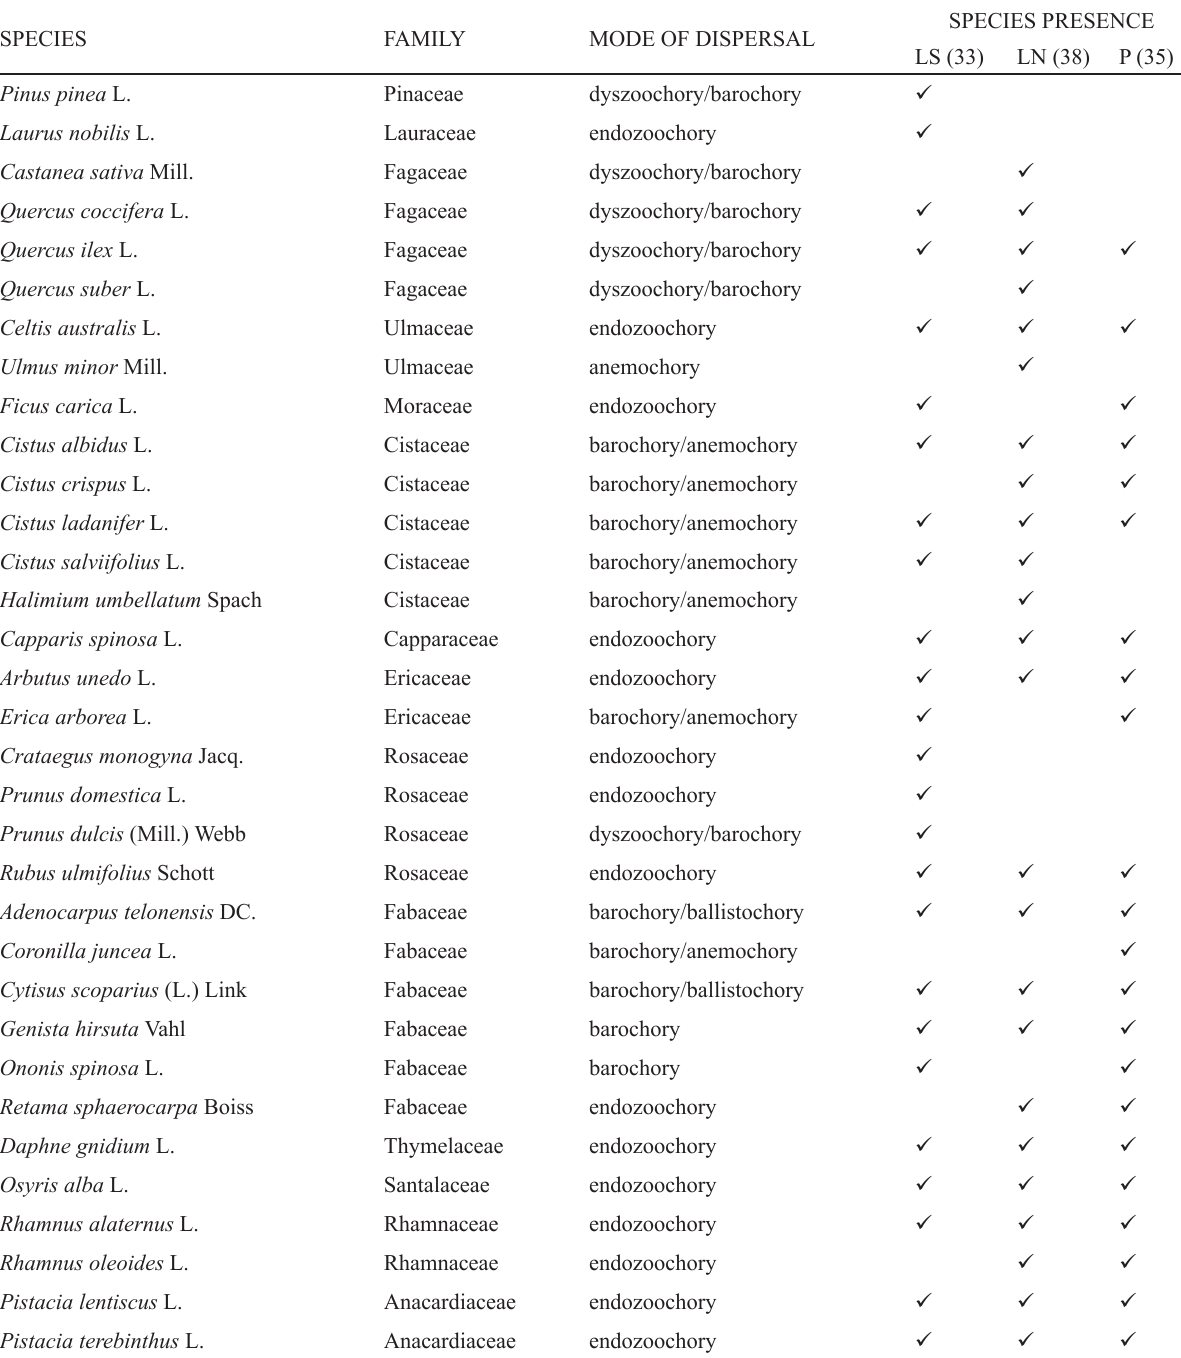
Table 1. List of sampled plant species and their main characteristics. Species are classified into and (ordered by) taxonomic families (according to López Tirado, 2018) and most common mode of seed dispersal is also noted (Alday et al. , 2011; Bonet & Pausas, 2004; Debussche & Lepart, 1992; González-Varo et al. , 2015; Herrera, 1995; La Mantia et al. , 2019; Martín Mosquero et al. , 2005; Parolin et al. , 2014; Pemán García et al. , 2013; Sánchez & Peco Vázquez, 2002; Voigt et al., 2011). Species presence at each site is also included (LS = La Soledad, LN = Las Niñas, P = Piquín). SPECIES FAMILY MODE OF DISPERSAL Pinus pinea L. Pinaceae dyszoochory/barochory  Laurus nobilis L. Lauraceae Castanea sativa Mill. Fagaceae Quercus coccifera L. Quercus ilex L. Quercus suber L. Celtis australis L. Ulmaceae